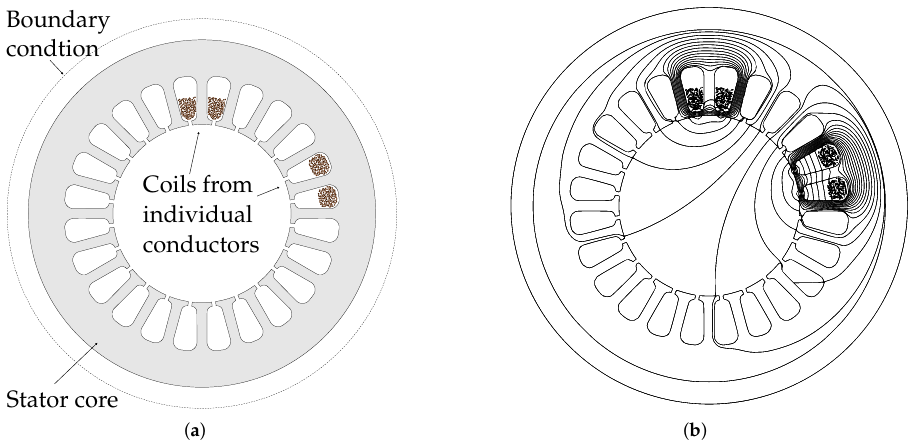
Figure 3. Two dimensional electrostatic field simulation model